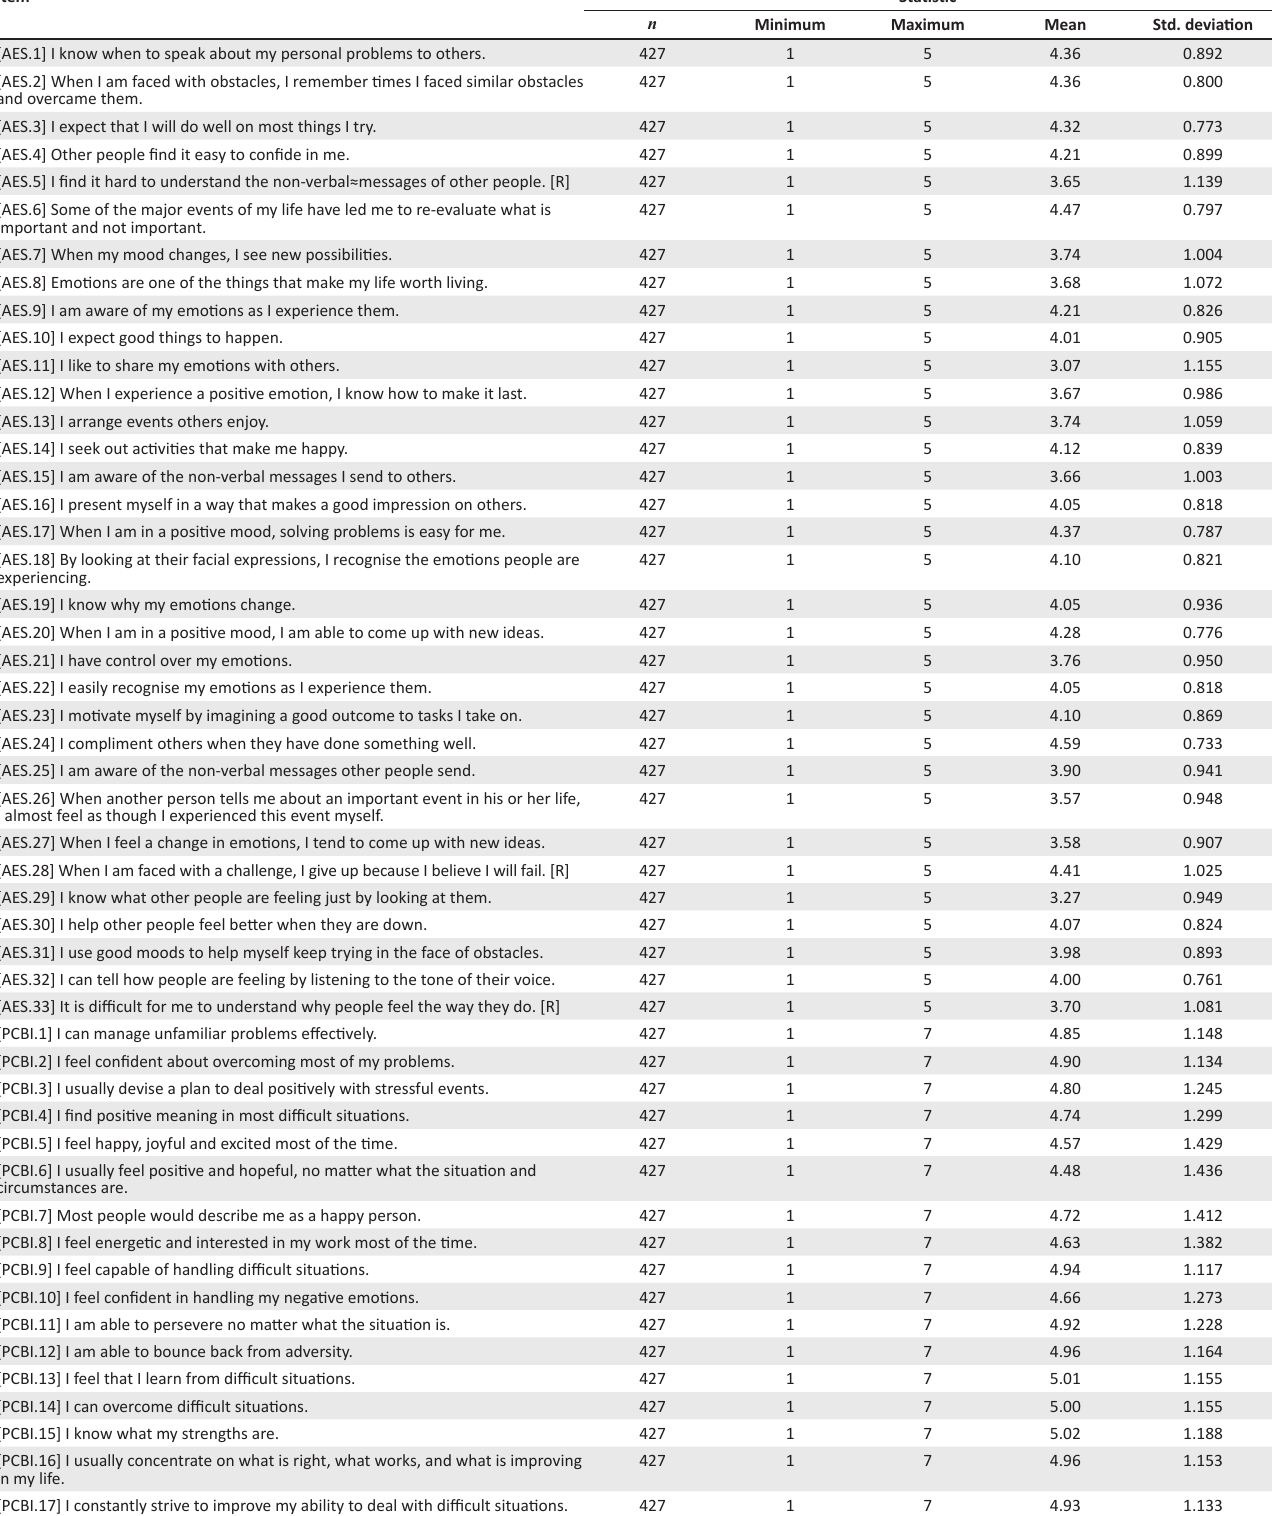
TABLE 1-A1: Descriptive statistics: Means and standard deviation at item